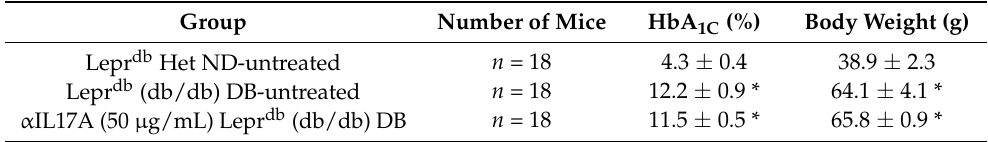
Table 4. Clinical data of db/db mice receiving weekly intraperitoneal injection of 50 µ g/mL of anti-IL-17A 2 months post-diabetes.